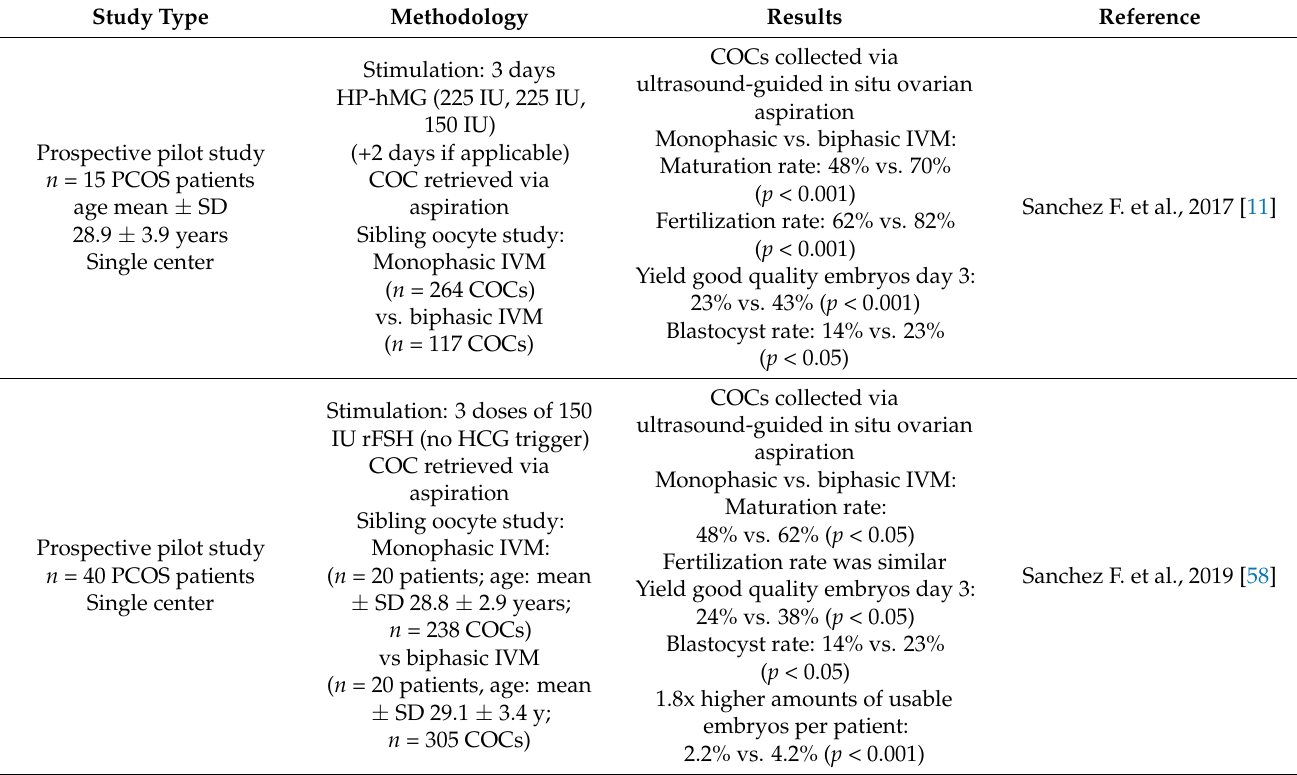
Table 3. Human studies comparing monophasic IVM vs. biphasic